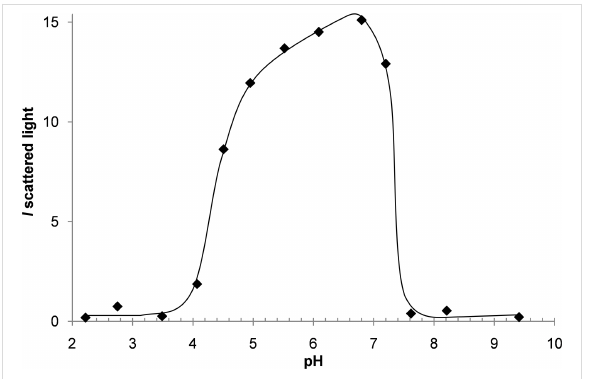
Figure 1: Variation of the scattered light intensity of PEO- b -PAA/OC mixtures ([AA] = 0.01 mol·L − 1 , N/AA = 0.8) as a function of